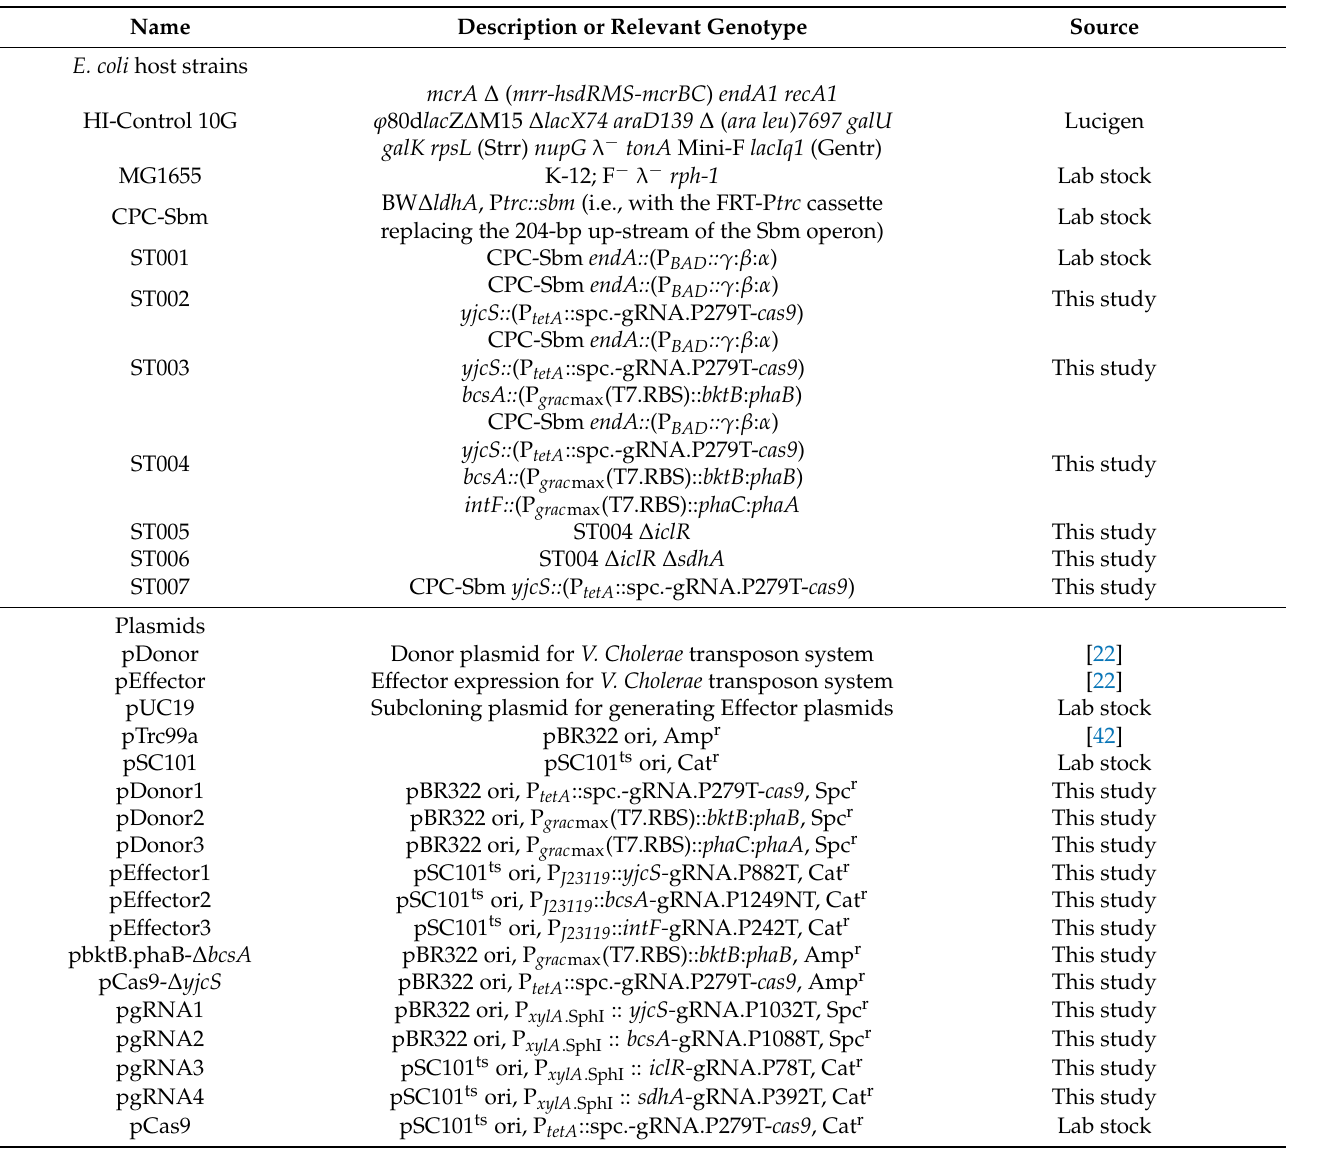
Table 1. E. coli strains and plasmids used in this